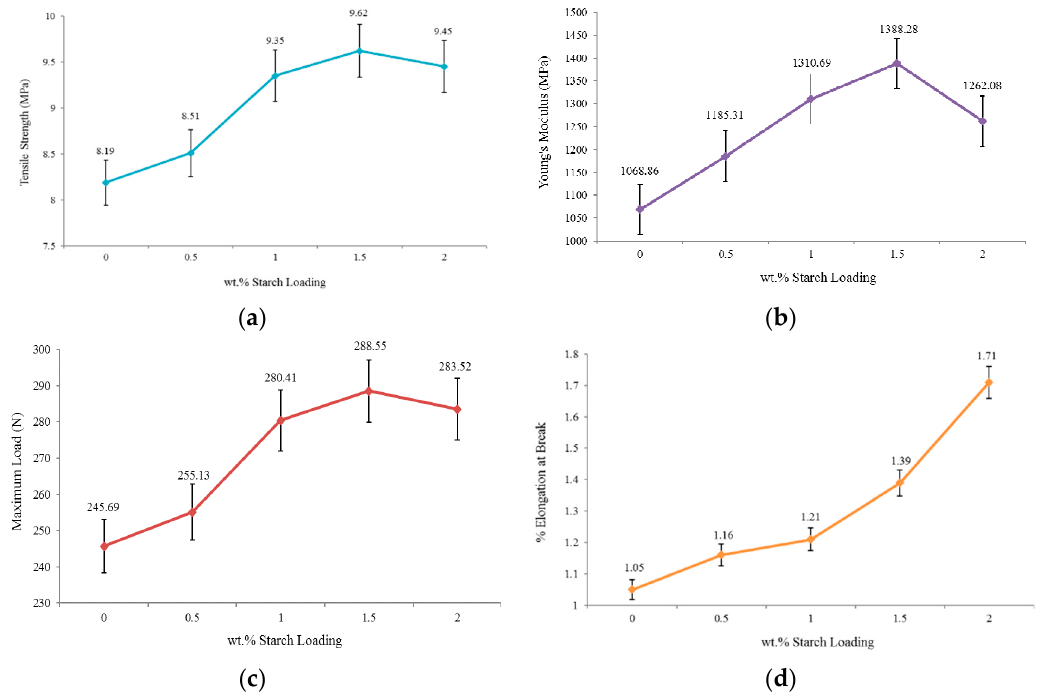
Figure 4. Mechanical tests of PU and PUS ( a ) tensile strength; ( b ) Young’s modulus; ( c ) maximum load; and ( d ) elongation at break.